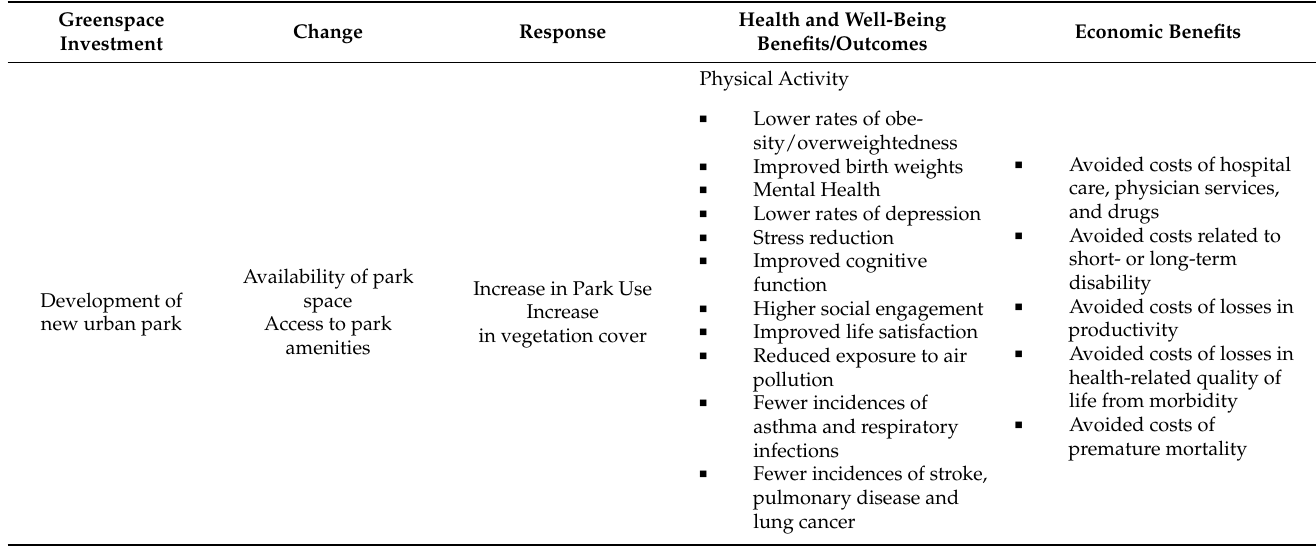
Table 1. Ecohealth framework applied to a new urban park.